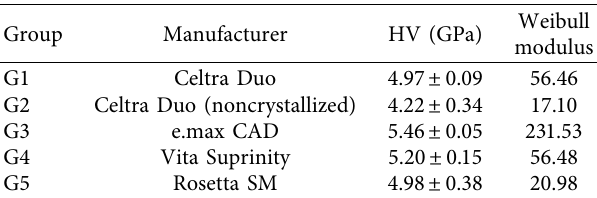
Figure 7: Weibull probability plot of the Vickers hardness of lithium disilicate Table 4: Vickers microhardness values and Weibull modulus for glass-ceramics.